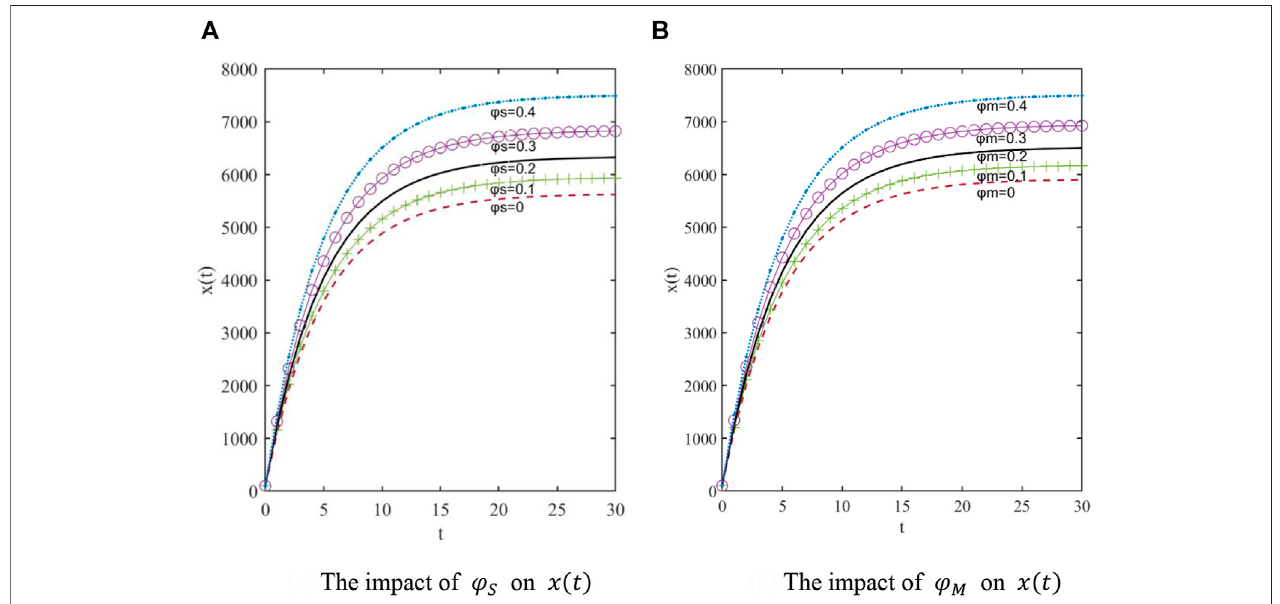
FIGURE 9 | The impact of government subsidies on x ( t ) . (A) The impact of φ S on x ( t ) . (B) The impact of φ M on x ( t ) .